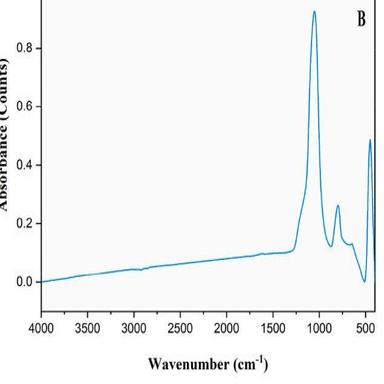
a) XRD of silica fume heat-treated at 900 & 1000 ◦C for 1 h, b) FT-IR of the raw silica fume.